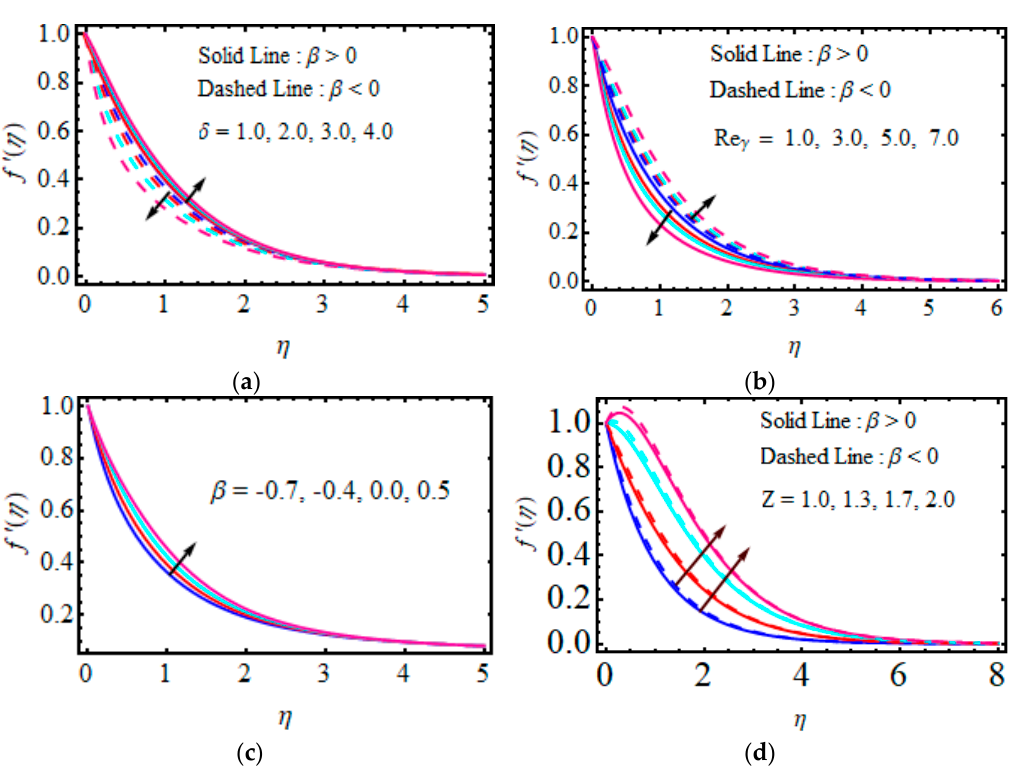
Figure 3. ( a – d ). The impact of the numerous variables 𝑜𝑓 𝑓 (cid:4593) (cid:4666)𝜂(cid:4667) : ( a ) 𝛿 , ( b ) 𝑅𝑒 (cid:3082) , ( c ) 𝛽 and ( d ) Z.